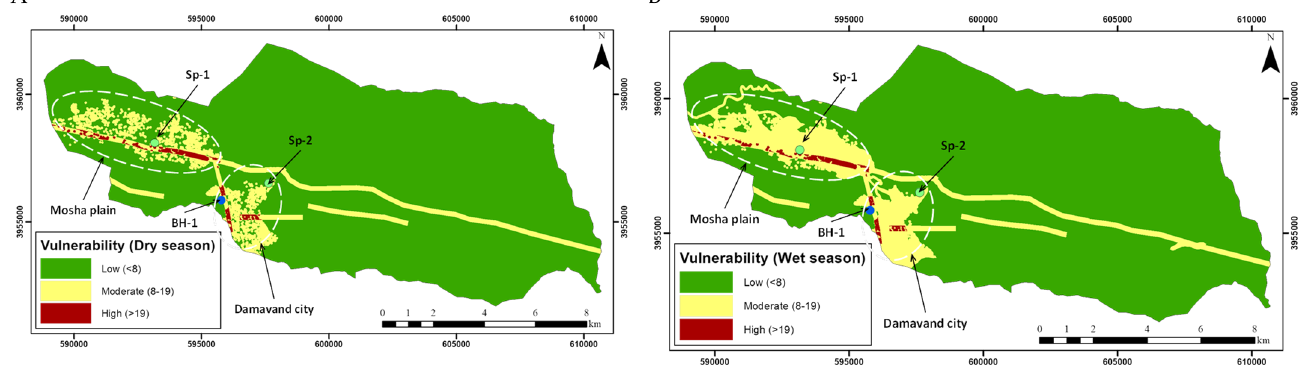
Figure 9. Risk maps of the Mosha Plain for the dry and wet seasons: ( A ) risk map of the dry season; ( B ) risk map of the wet season.